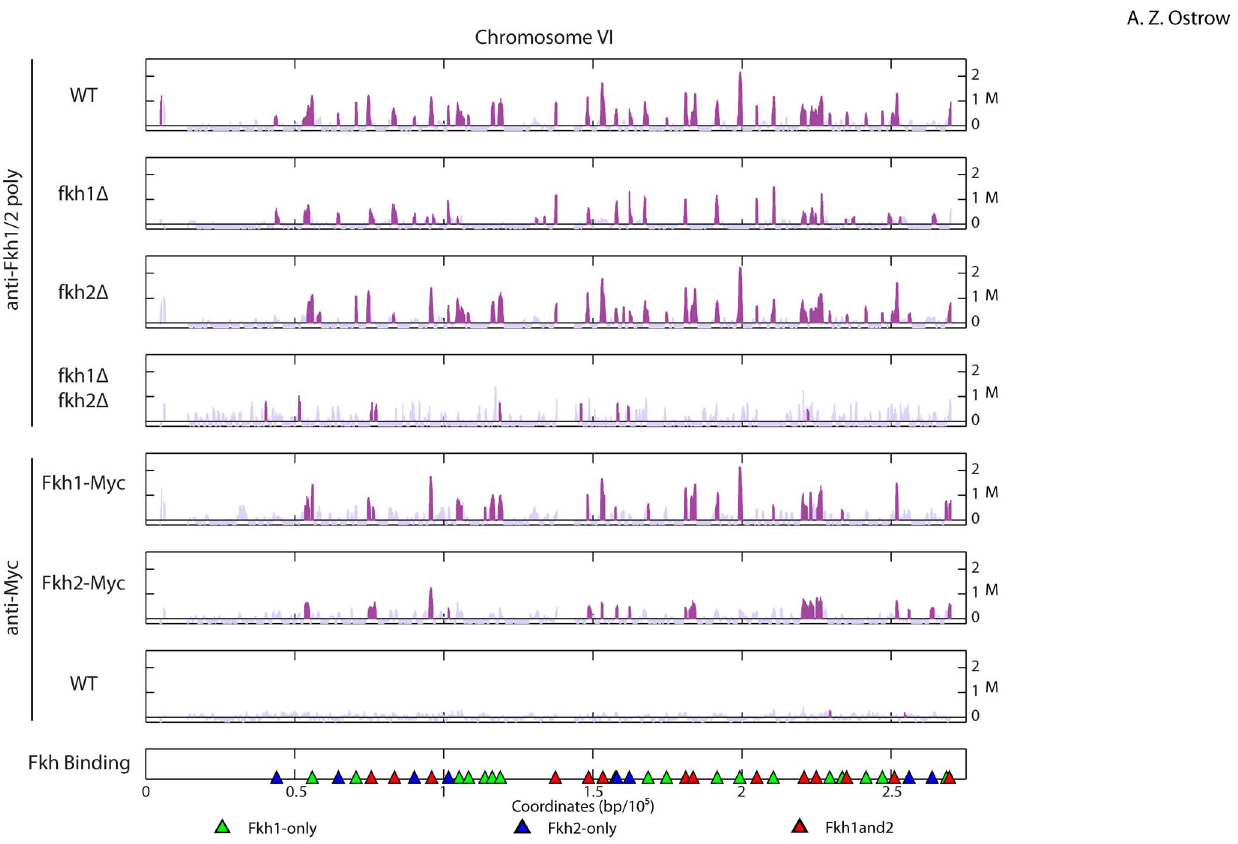
Figure 1. Genome-wide analysis of Fkh1 and Fkh2 chromatin binding. Plots show averaged ChIP-chip signal (M) from three experimental replicates along chromosome VI, with enriched regions plotted in purple. The antibody and strain genotype used for each experiment are indicated to the left of each panel; the corresponding strains from top to bottom are: CVy43, ZOy1, CVy138, CVy139, ZOy3, ZOy4, and CVy43. Triangles on the bottom panel indicate the position of determined binding sites as described in the text, color-coded by